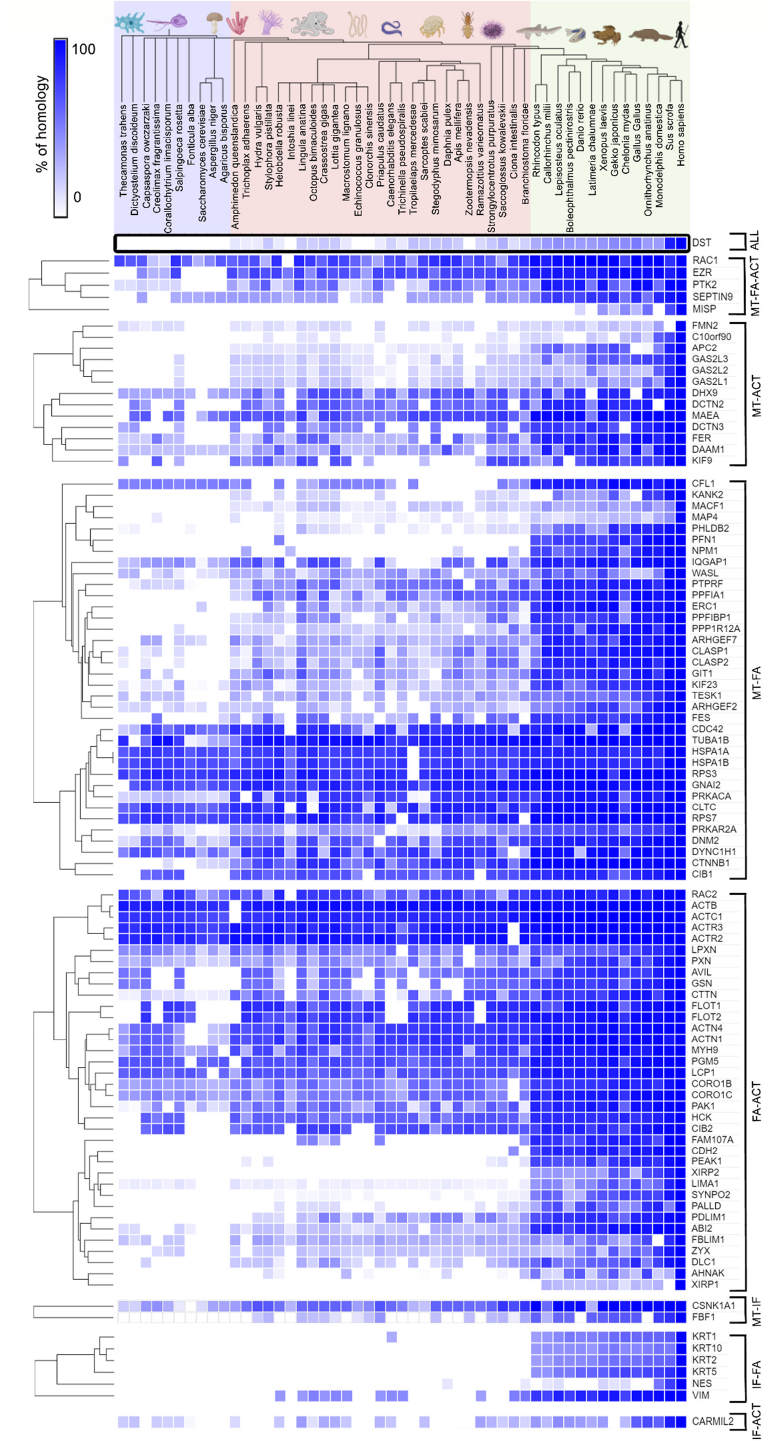
Figure 3. Evolutionary conservation of cytoskeletal crosstalk proteins. Heatmap representing percent- age of homology for crosstalk proteins found at the crossing points of the microtubules (MT), focal adhesions (FAs), intermediate filaments (IFs), and actin (ACT) in human cytoskeleton datasets. The proteins found at the crossing points were classified according to their occurrence in the respective datasets, and hierarchical clustering (Euclidean distance algorithm and average linkage method) was performed for each group separately using the Morpheus online